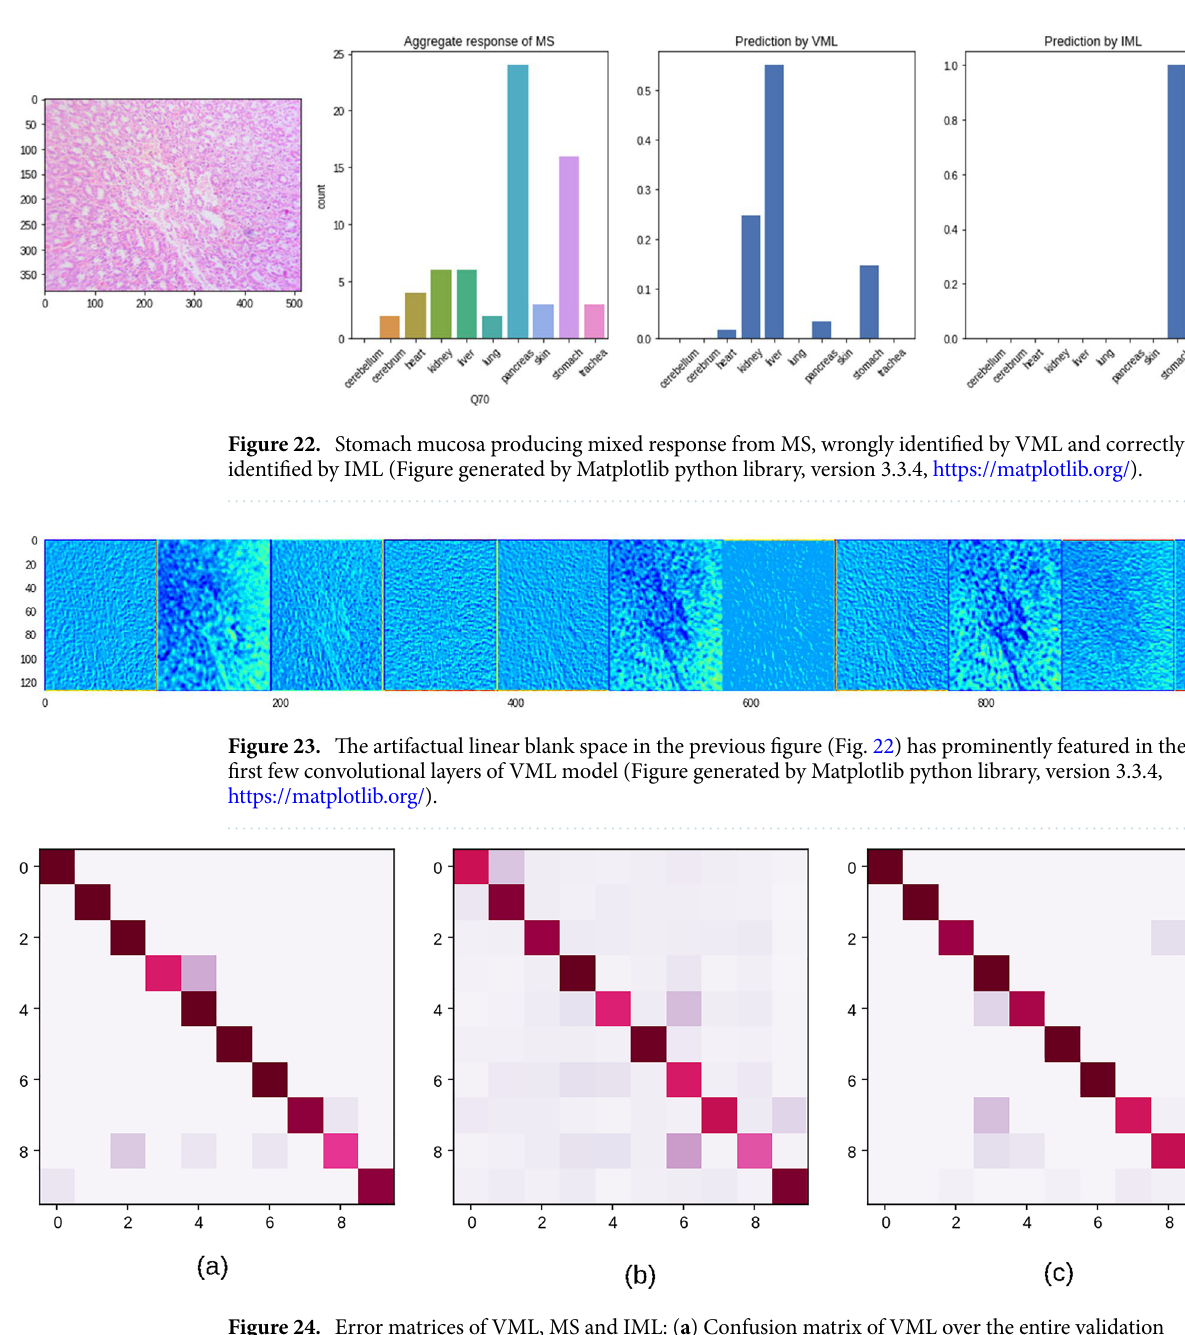
Figure 24. Error matrices of VML, MS and IML: ( a ) Confusion matrix of VML over the entire validation set ( n = 300); the dark spots along the diagonal represent correct answers; ( b ) Aggregated confusion matrix of medical students over the quiz images ( n = 6557); dark spots are noted outside the diagonal line, representing wrong answers; ( c ) Confusion matrix of IML model on validation set ( n = 300); the IML is more accurate, and shows less equivocal predictions, than the VML model (Figure generated by Matplotlib python library, version 3.3.4, https:// matpl otlib.